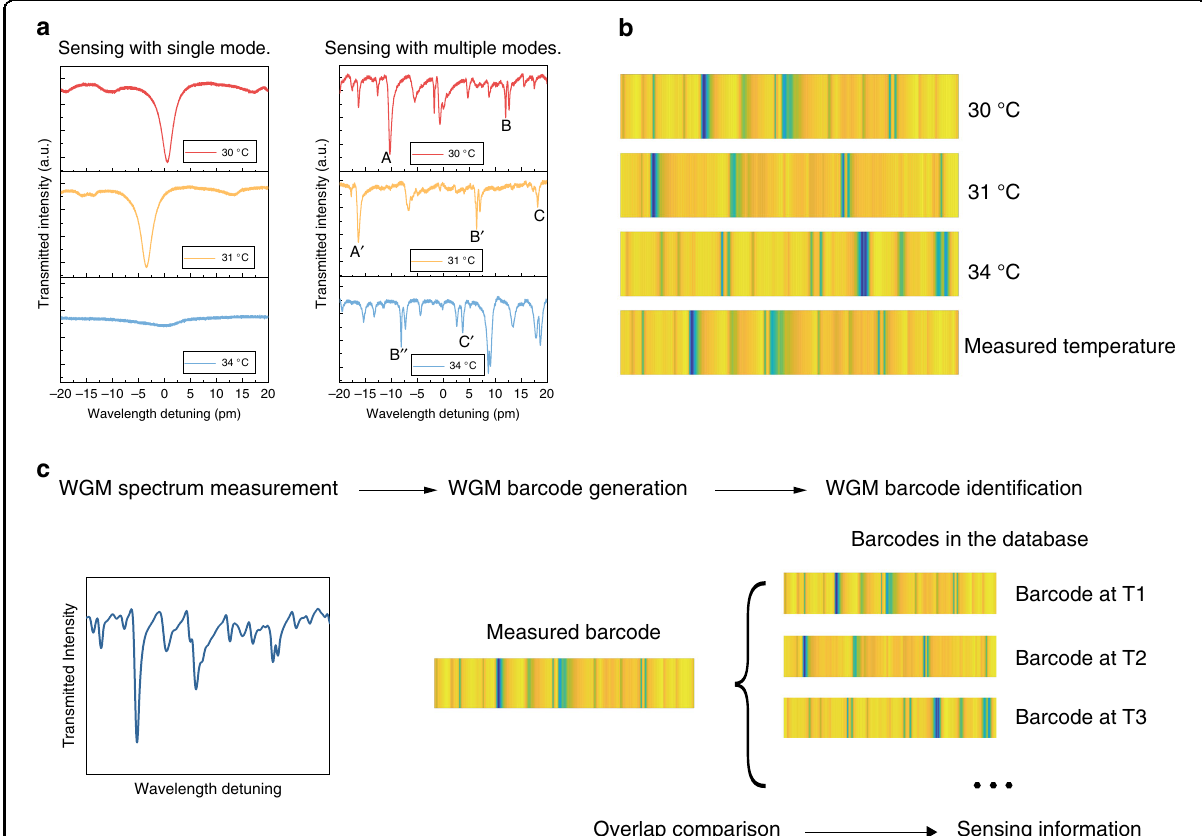
Fig. 2 Demonstration of the WGM barcode technique. a A comparison between the WGM spectra for the conventional single-mode tracking method (left) and the proposed barcode sensing with multiple modes (right). In the WGM spectra for single-mode tracking, tracking of resonance is not possible as the mode shifts out of the scanning range at 34 °C. In the WGM spectra for barcode sensing with multiple modes, the resonant wavelengths, spacing between modes, linewidths, and coupling depths are determined by the temperature. b Optical barcodes generated at different temperatures. Each line represents a mode from the spectrum. The resonant wavelengths, linewidths, coupling depths, and spacing between modes are converted to the positions, widths, colours, and distance between lines in the barcode. The measured temperature should be close to 30 °C or 31 °C, rather than 34 °C, based on their pattern similarities. c Work fl ow of sensing with optical barcodes. During measurement, the WGM spectrum is measured, and a barcode is subsequently generated. By comparing the pattern of the measured barcode with the barcodes in the database, the sensing information can be extracted